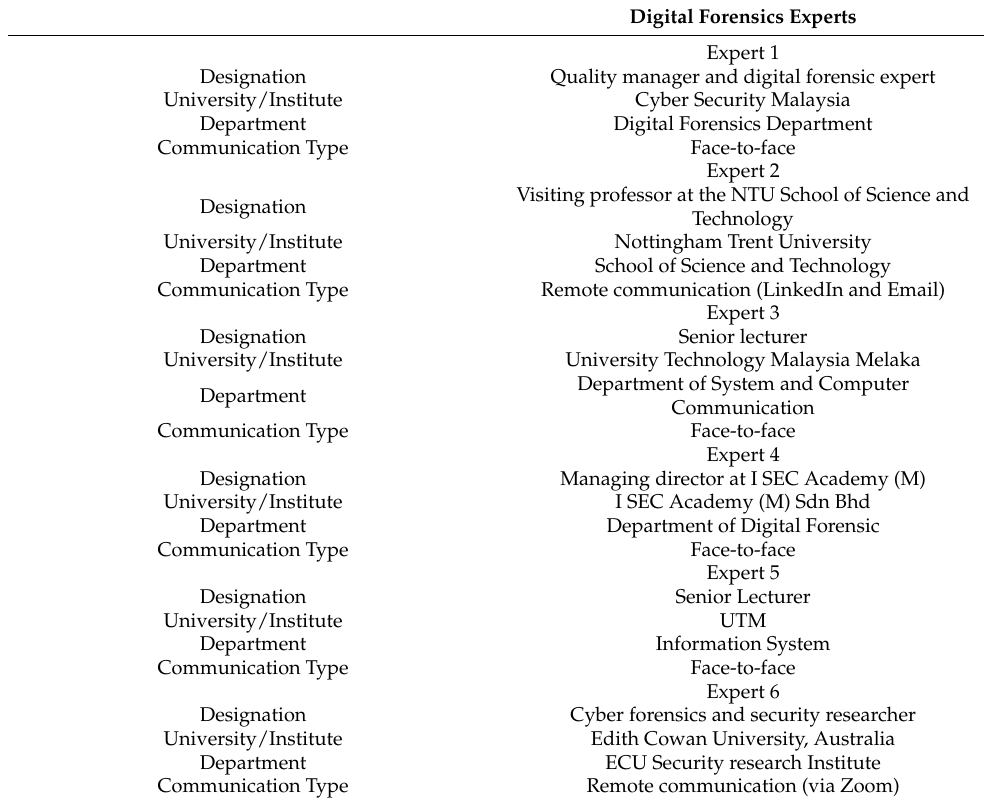
Table 2. Metamodel validation